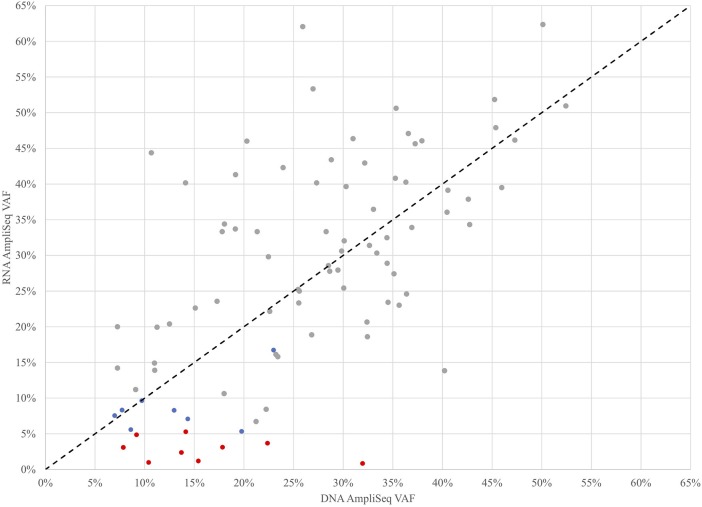
Variant Allele Frequencies (VAF) determined by targeted DNA and RNA AmpliSeq methods for 102 FNAs that were variant positive by DNA AmpliSeq. Samples with low RNA AmpliSeq coverage of the variant were excluded. Gray points were detected by all 3 methods, blue points were detected by DNA AmpliSeq and RNA AmpliSeq, but not detected by XA, red points were detected by DNA AmpliSeq but not RNA AmpliSeq or XA. The black dotted line is x=y.